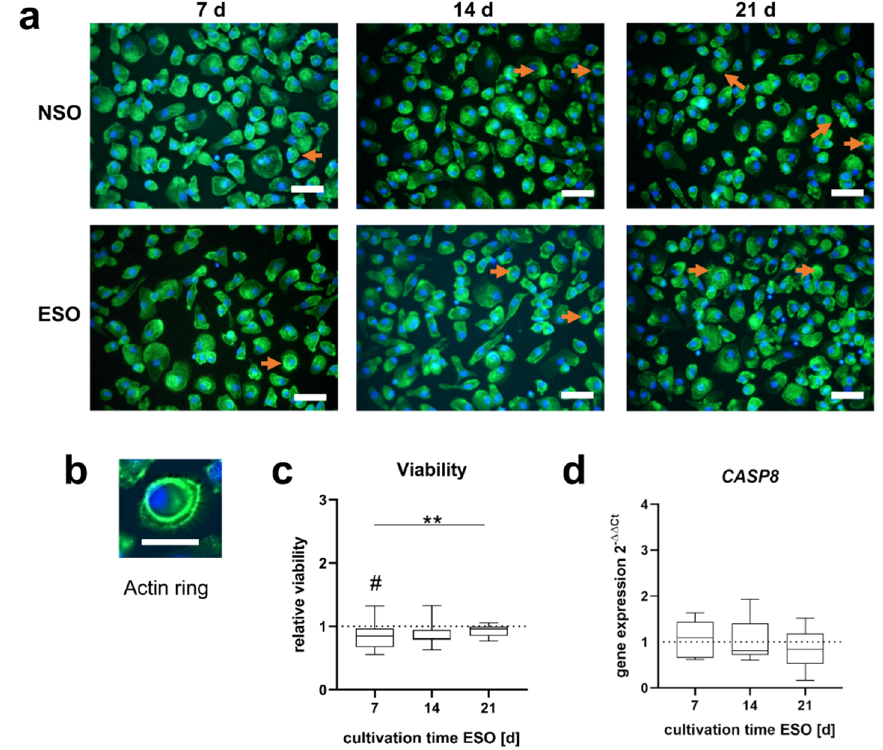
Figure 3. Morphology and viability of PBMCs after 48 h incubation with pooled supernatant of osteoblast stimulated over 7, 14, and 21 d (ESO) and without electric stimulation (NSO). ( a ) Mor- phology of PBMCs. The actin skeleton is visualized in a green color and the nucleus in blue.